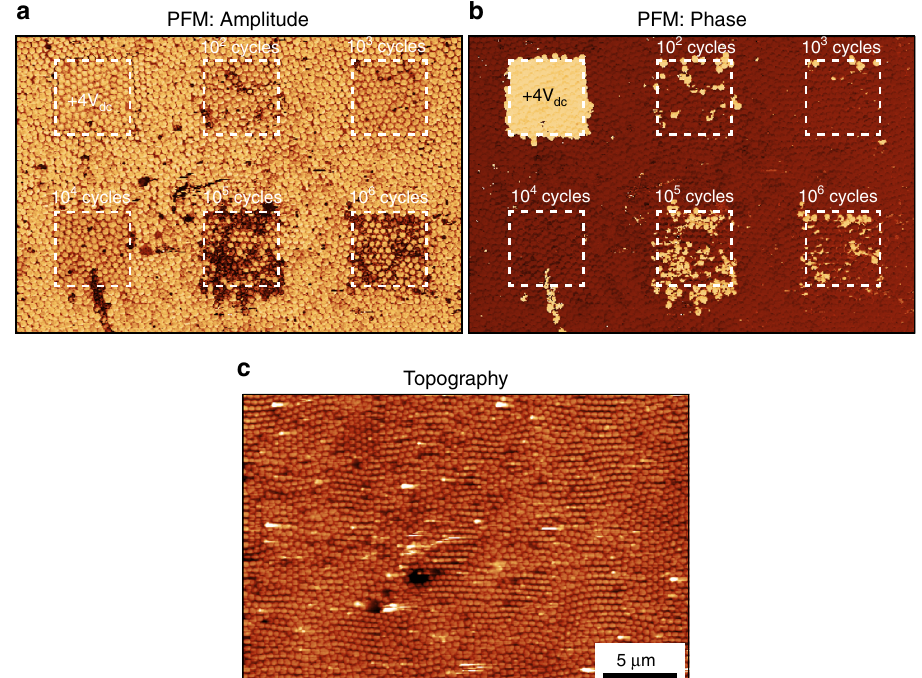
Fig. 3 PFM imaging of regions cycled with different numbers of switching pulses (from 10 2 to 10 6 as labeled). a PFM amplitude; b PFM phase; and c